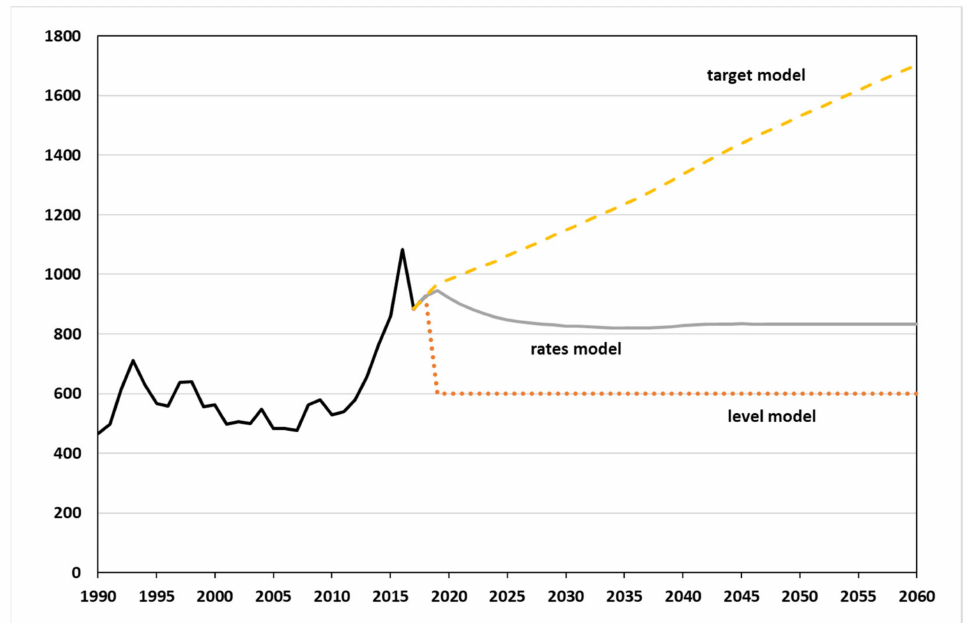
Figure 4. Emigration of the non-German population until 2060 (in k)—simulation results from 2019 onwards. (Sources: [57]; own computation and